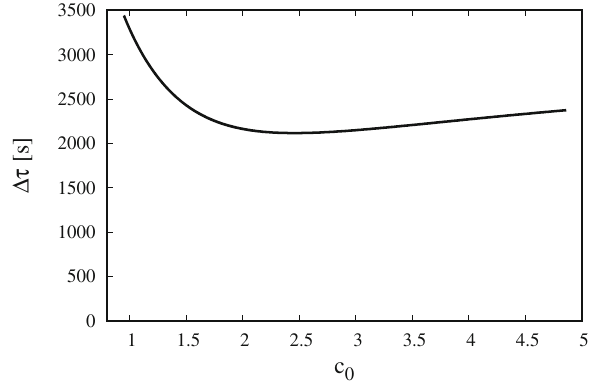
Fig. 6 Minimum radius of the wormhole throat r min normalized by c as a function of c 0